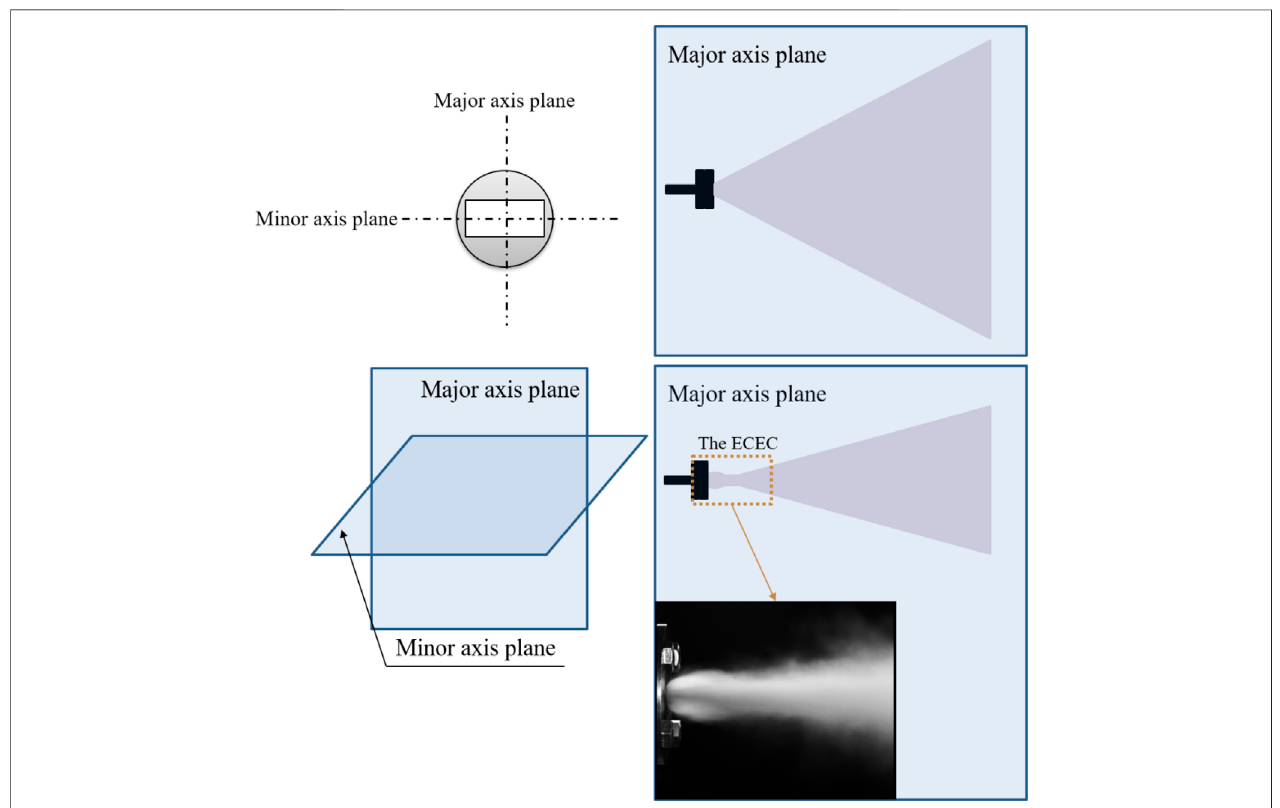
FIGURE 5 | The con fi guration of the supercritical CO 2 jet from a rectangular ori fi ce.